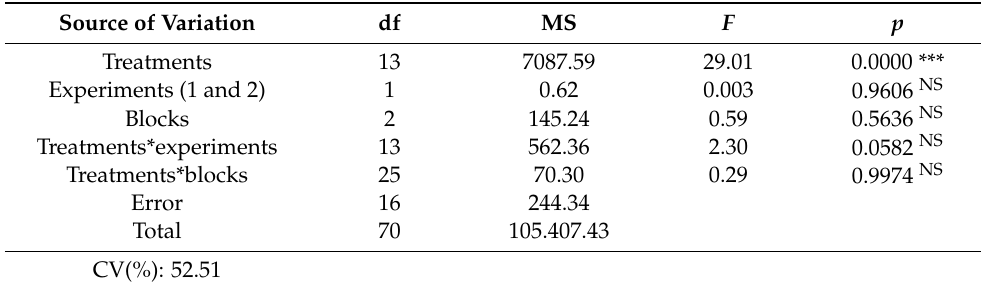
Table 4. Analysis of variance of the biocontrol potential of Pseudomonas and Trichoderma species in reducing blast severity in wheat cv. Sossego.